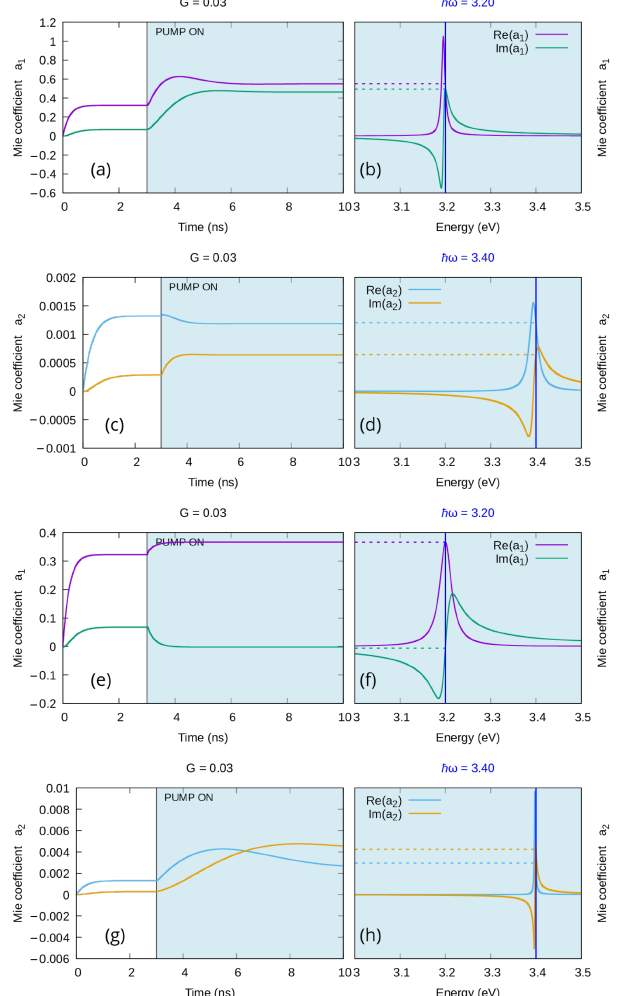
Figure 4. Real and imaginary part of the first two coefficients of the Mie expansion of the scattered field for a silver nanoparticle of radius 60 nm in water enriched with a gain medium below the emission threshold G = 0.03 with emission bandwidth ∆ = 0.15 eV. ( a – d ): the emission central frequency ¯ h ω 21 = 3.19 eV was chosen to correspond to the resonance frequency of the dipolar mode. ( e – h ): the emission central frequency ¯ h ω 21 = 3.4 eV was chosen to correspond to the resonance frequency of the quadrupolar mode. ( a , b , e , f ): coefficient a 1 dipolar mode; ( c , d , g , h ): coefficient a 2 quadrupolar mode; ( a , c , e , g ): time dependencies for a single frequency; ( b , d , f , h ): corresponding steady state